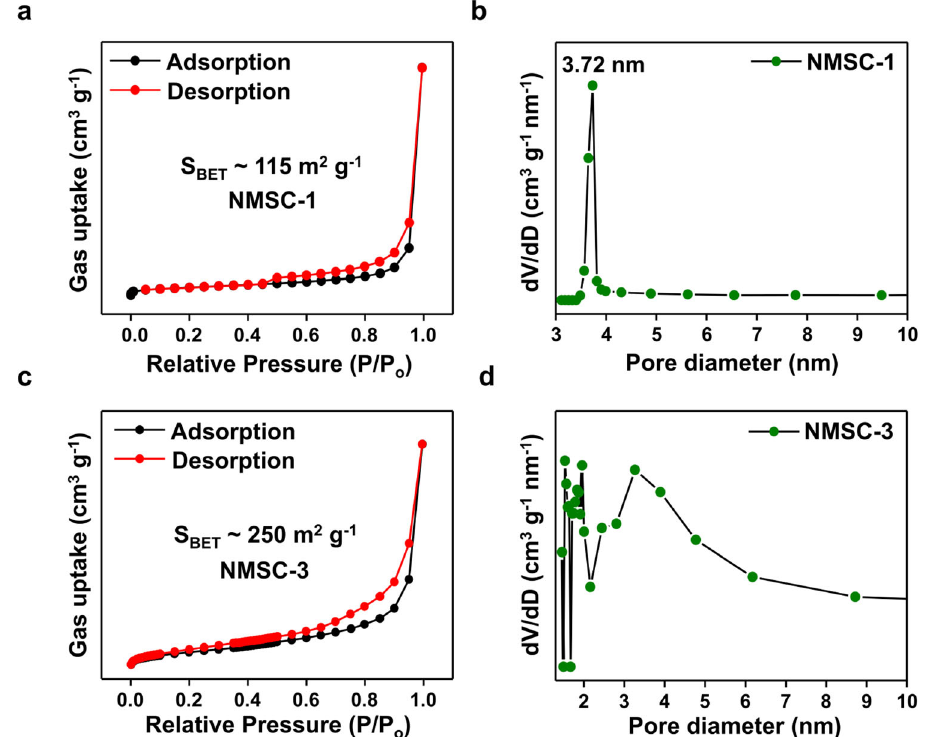
Fig. 2 | Pore characteristic control in NMSC via stoichiometric ratio. a – d Structural variations with speci fi c surface areas and pore-size distributions of a , b layered NMSC-1 and c , d amorphous NMSC-3. Source data are provided as a Source Data fi